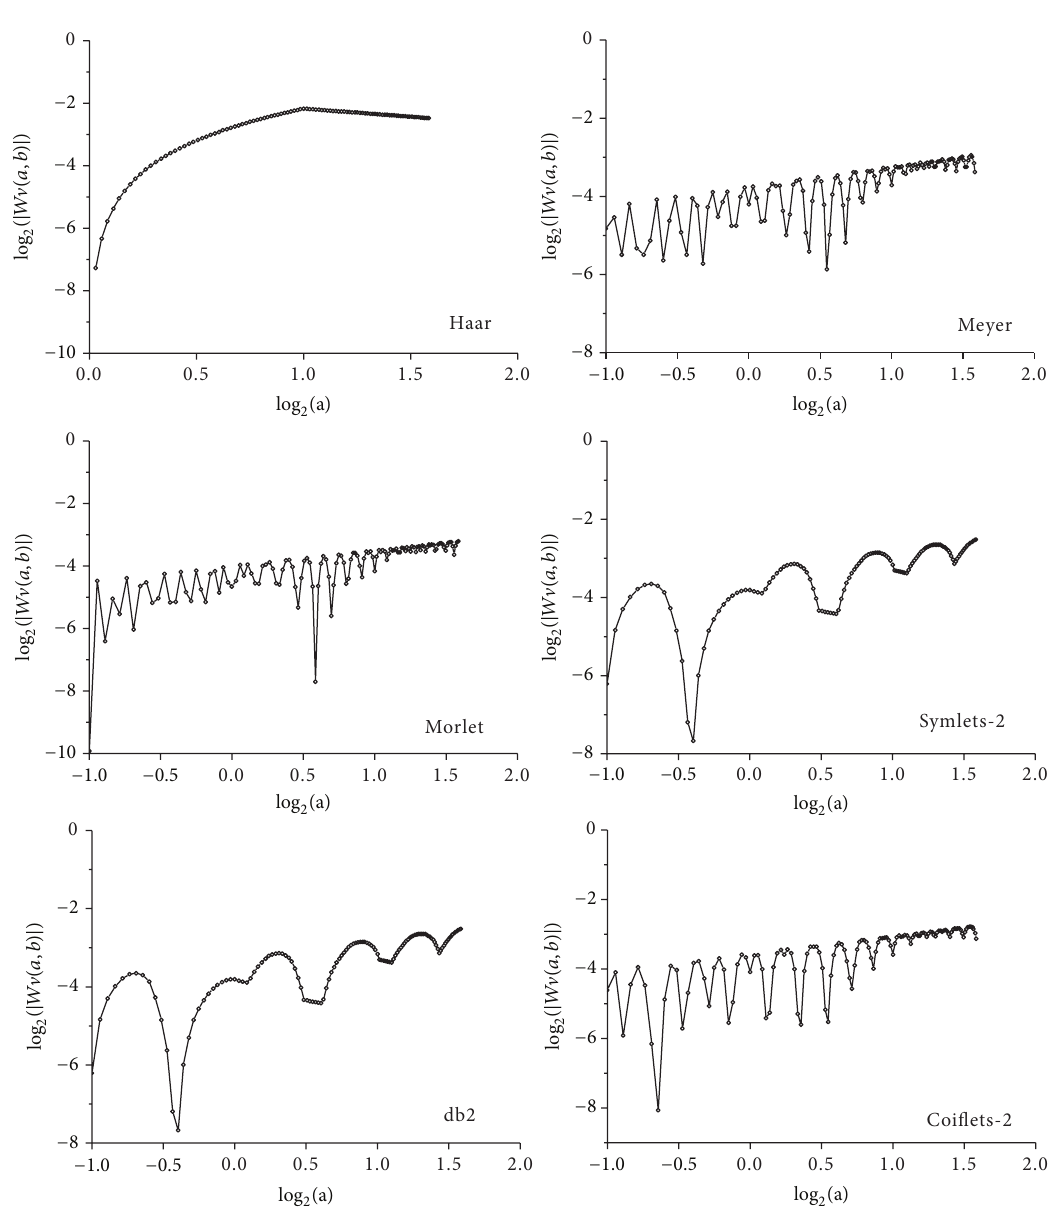
Figure 11: Decay behaviour along the modulus maxima line using different mother